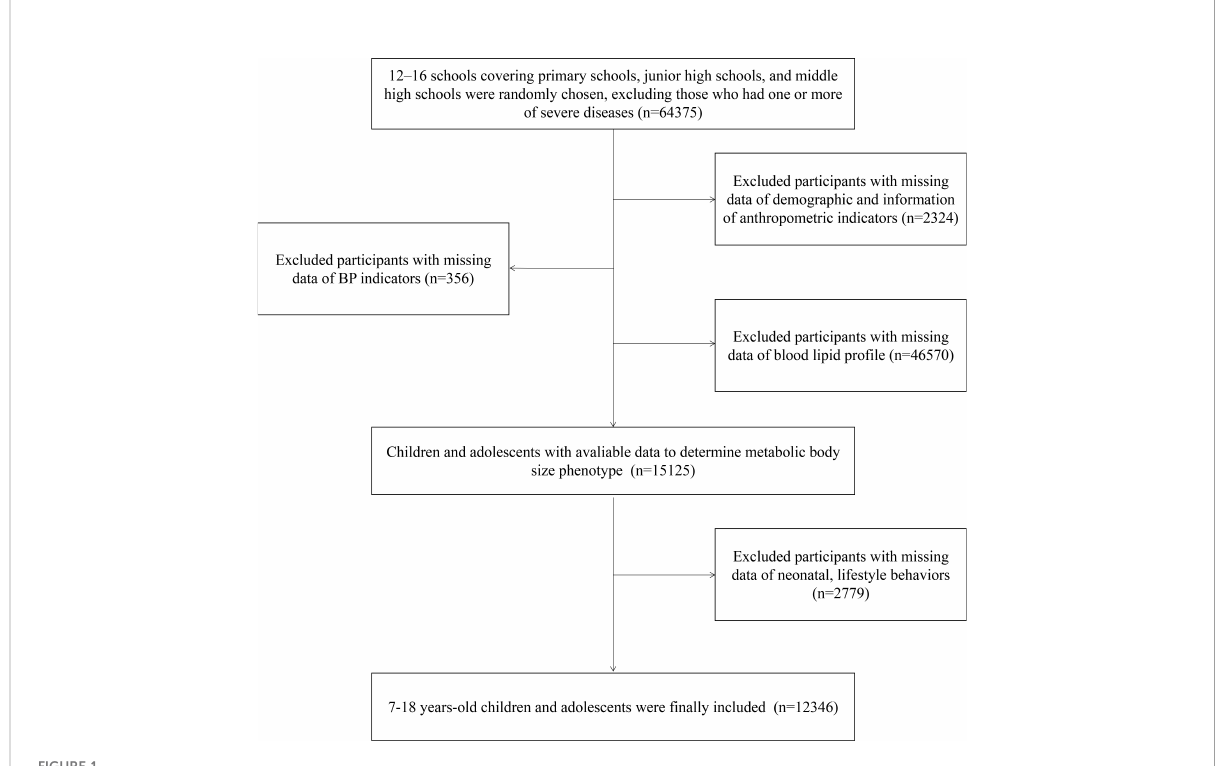
FIGURE 1 Flow diagram of study population